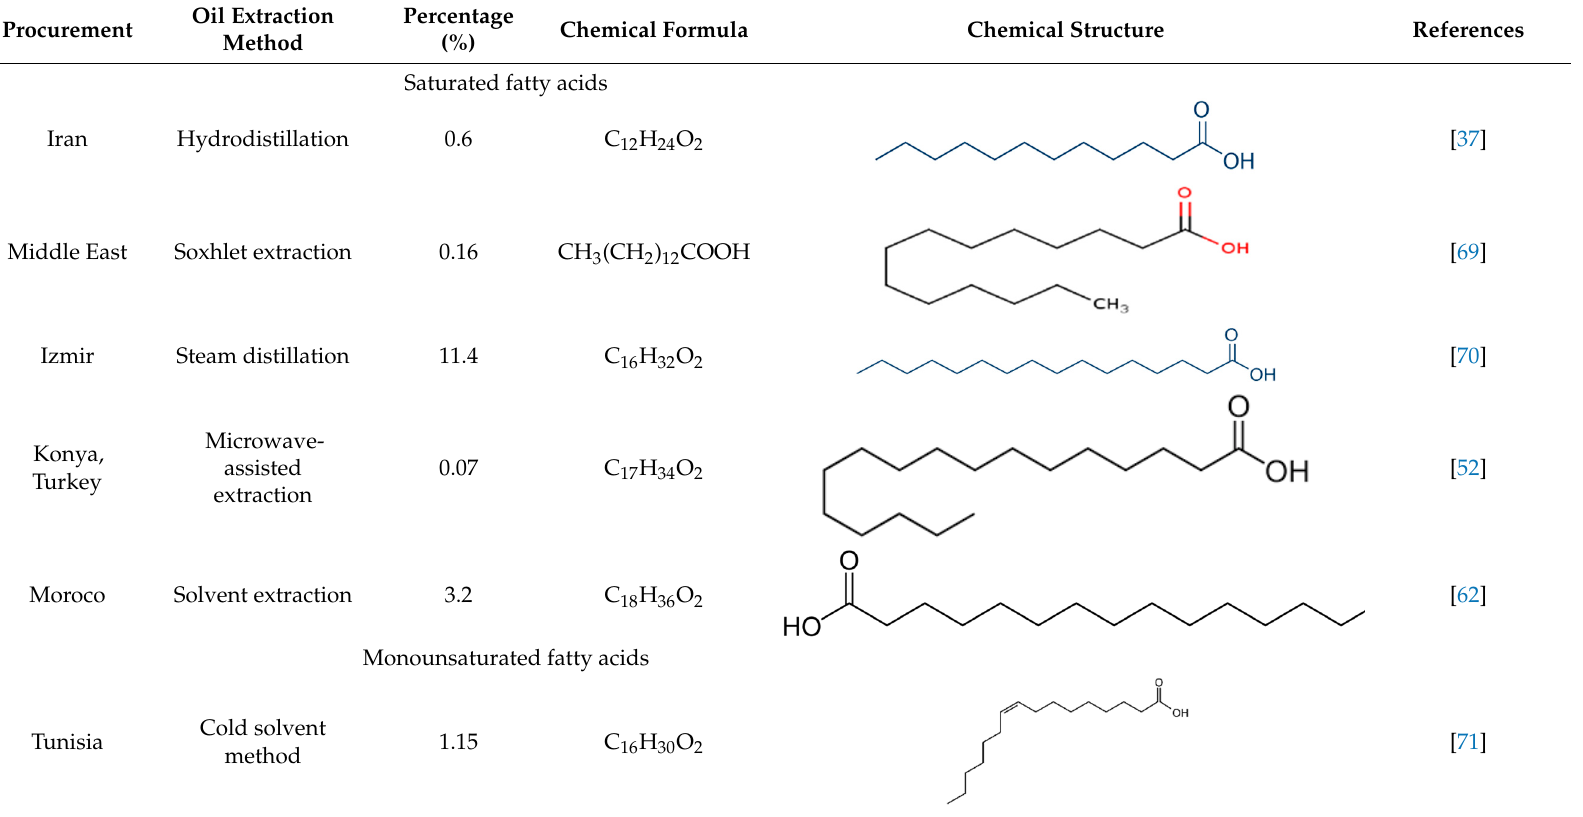
Table 2. Fatty acids profile of Nigella sativa seed oil.